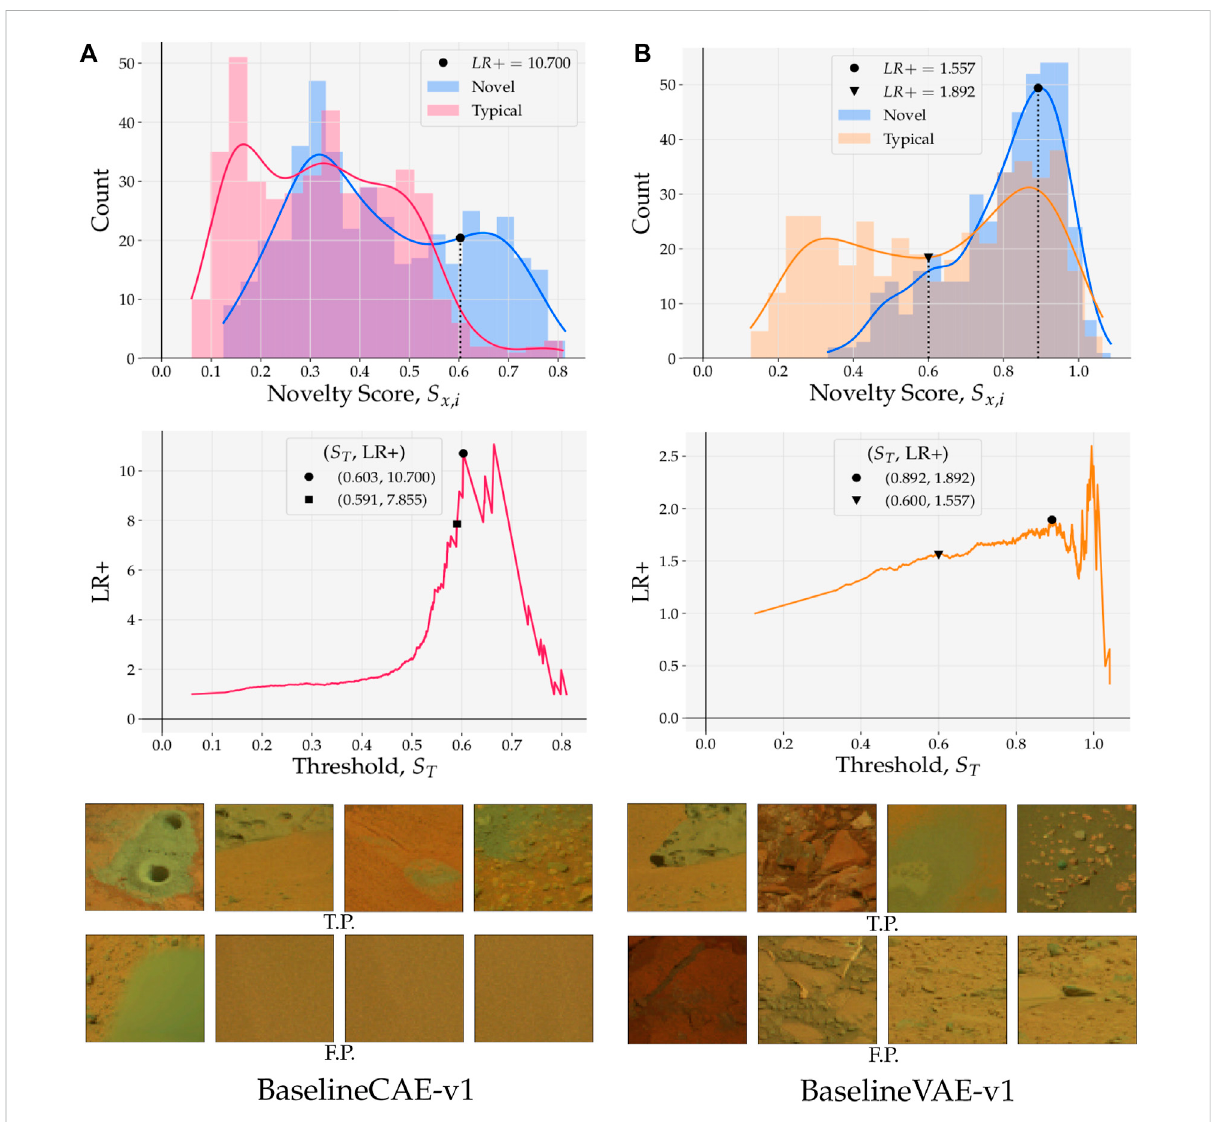
FIGURE 10 ( top )Reconstruction scoredistributions fortypicalandnovel samples; approximated probabilitydensitieswerecalculated with Gaussiankernel density estimation. Thresholds S T placed on novelty scores S establish a boundary that separates positive (novel) and negative (typical) class predictions. ( middle ) Positive likelihood ratio (LR+) as a function of novelty boundary/threshold S T . LR+ provides information about the relative strength of the true positive rate against the false positive rate. ( bottom ) Examples of true positive (TP) and false positive (FP) samples predicted (cid:129) by models with S T set at the point marked by . (A) BaselineCAE-v1. (B)